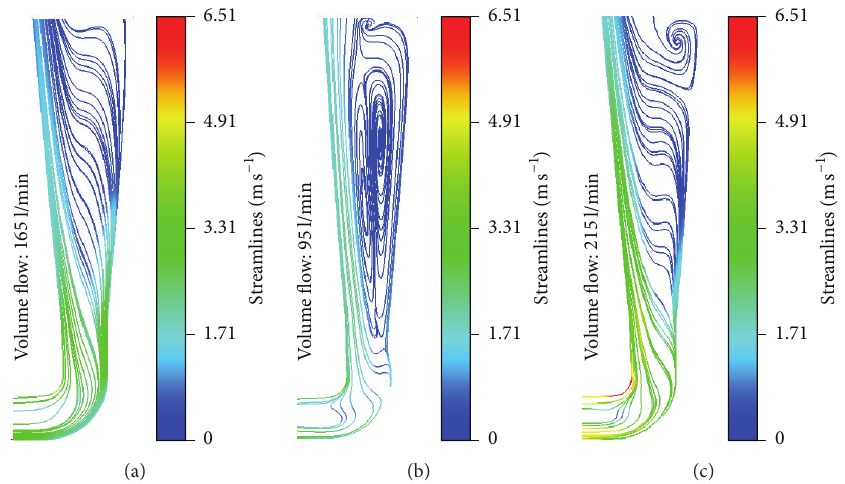
Figure 13: Streamlines in draft tube at midplane for different operating conditions.